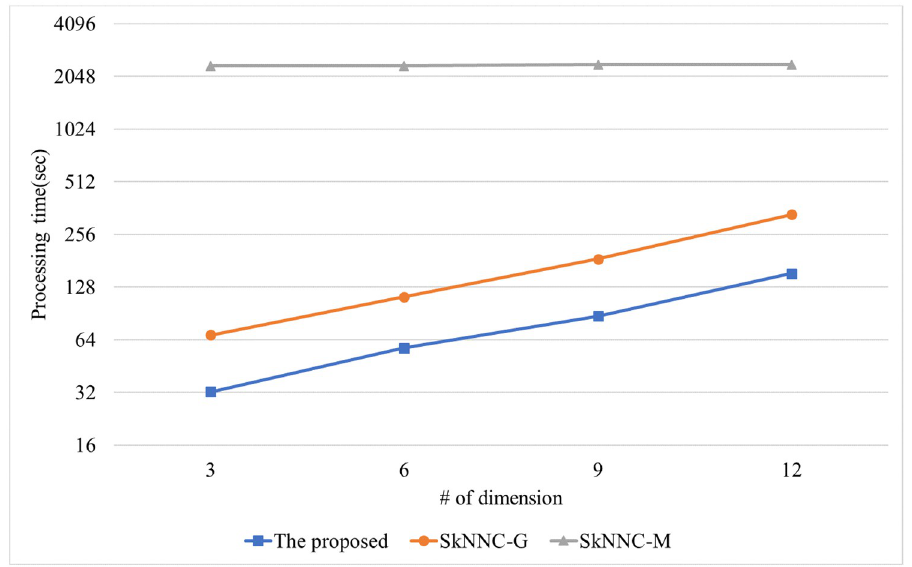
Fig 12. Processing time with varying the number of dimensions.